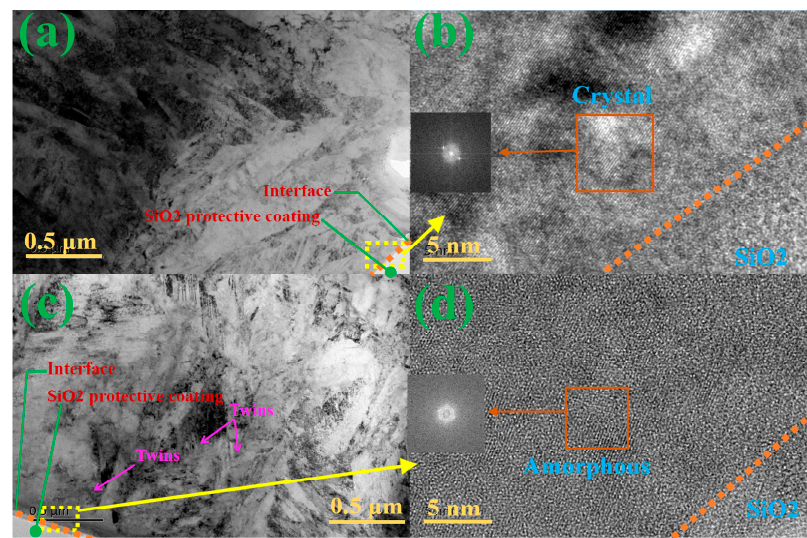
Figure 8. The comparative microstructures of pristine M50 matrix without and with implantation: ( a ) Microstructure with no implantation; ( b ) magnified image showing morphology at transition, corresponding to the yellow box in ( a ); ( c ) Microstructure with implantation; ( d ) magnified image showing morphology at transition, corresponding to the yellow box in ( c ).